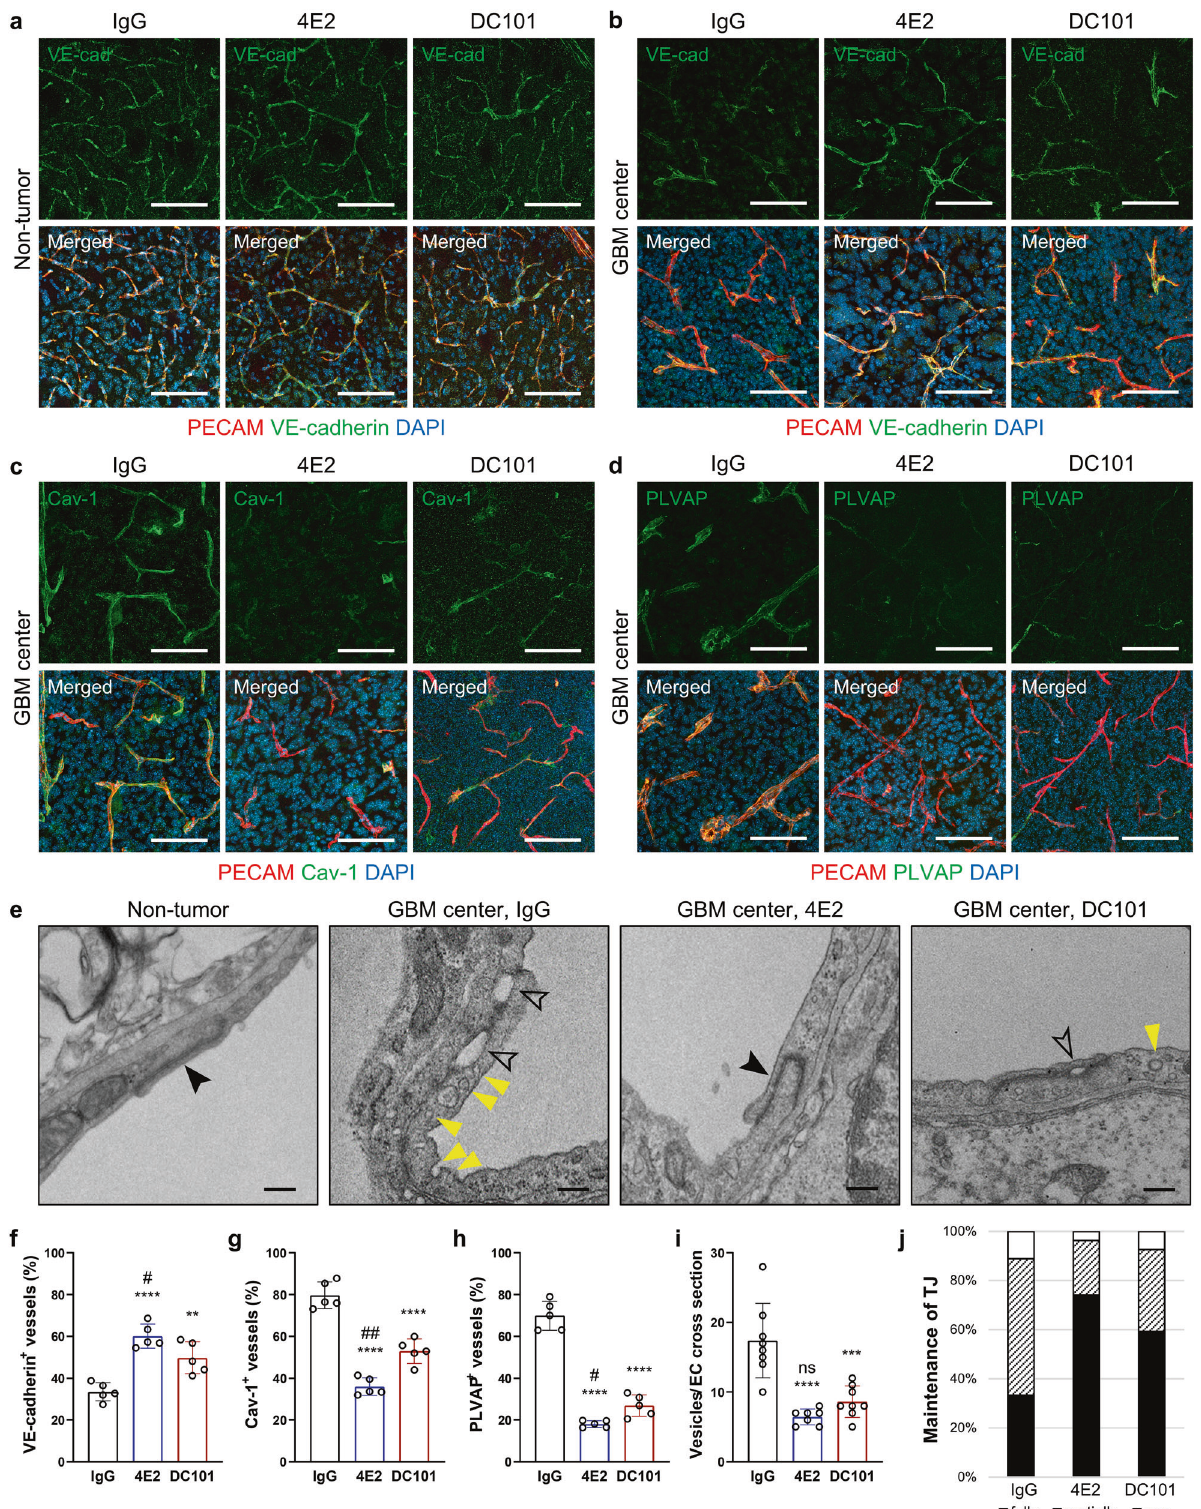
Fig. 6 Antibody-based Tie2 activation and VEGFR2 blockade stabilize EC junctions and suppress EC transcytosis in GBM. Vascular assessment in EGFR VIII GBMs at 2 weeks post-treatment with IgG, 4E2, or DC101. a , b Immunostaining for VE-cadherin in nontumor vessels ( a ) and GBM vessels ( b ), with quanti fi cation ( f , n = 5 per group). c Immunostaining for Caveolin-1, a transcytosis marker, in tumor vessels, with quanti fi cation ( g , n = 5 per group). d Immunostaining for PLVAP, a transcytosis marker, in tumor vessels, with quanti fi cation ( h , n = 5 per group). e Transmission electron micrographs showing caveolar vesicle formation (yellow arrowheads) and cell-cell junctions in ECs of normal brain and GBM treated with IgG, 4E2, or DC101. The closed and open arrowheads indicate intact tight junctions and destabilized junctions, respectively. i Quanti fi cation of vesicles per EC cross-section ( n ≥ 7 per group). j Proportion of intact tight junctions (TJs) ( n = 27 per group). Scale bars: 100 µm ( a - d ), 200 nm ( e ). **, P < 0.01; ***, P < 0.001; ****, P < 0.0001 vs. IgG. ns not signi fi cant; #, P < 0.05; ####, P < 0.0001 vs.